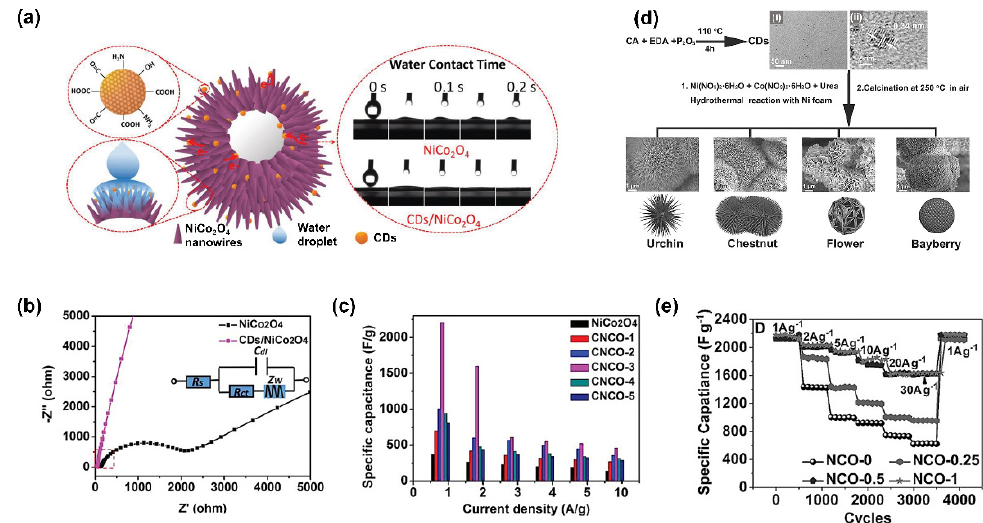
Figure 7. ( a ) Schematic illustration of the CD effect on NiCo 2 O 4 hydrophilicity properties. ( b ) Nyquist plots of the NiCo 2 O 4 and CDs/NiCo 2 O 4 electrodes. ( c ). The specific capacitance of NiCo 2 O 4 and CDs/NiCo 2 O 4 in varying current densities: reproduced from Reference [132]. Copyright John Wiley and Sons, 2019. ( d ) The CDs/NiCo 2 O 4 composites with different morphologies prepared using a uniform size of CDs. (i) The corresponding TEM image of the as-synthesized CDs and (ii) High-Resolution TEM image of the as-synthesized CDs. ( e ) Cycling stability and rate performance of CDs/NiCo 2 O 4 composites at various current densities: reproduced from Reference [133]. Copyright John Wiley and Sons, 2016.